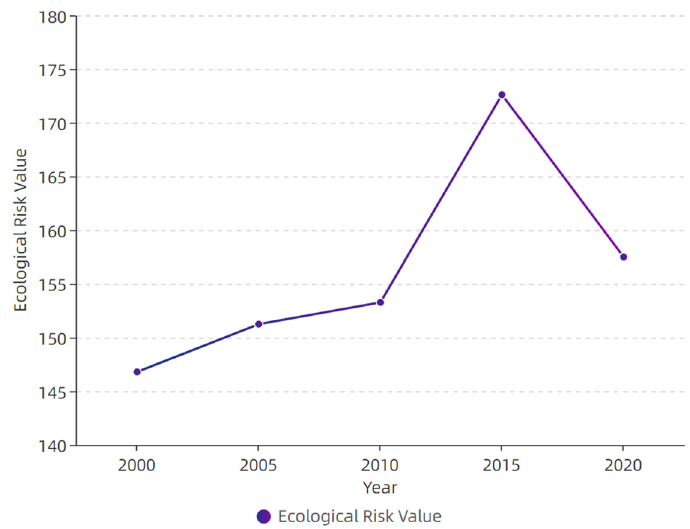
Figure 11. Overall landscape ecological risk values of Zhangjiachuan County from 2000 to 2020.